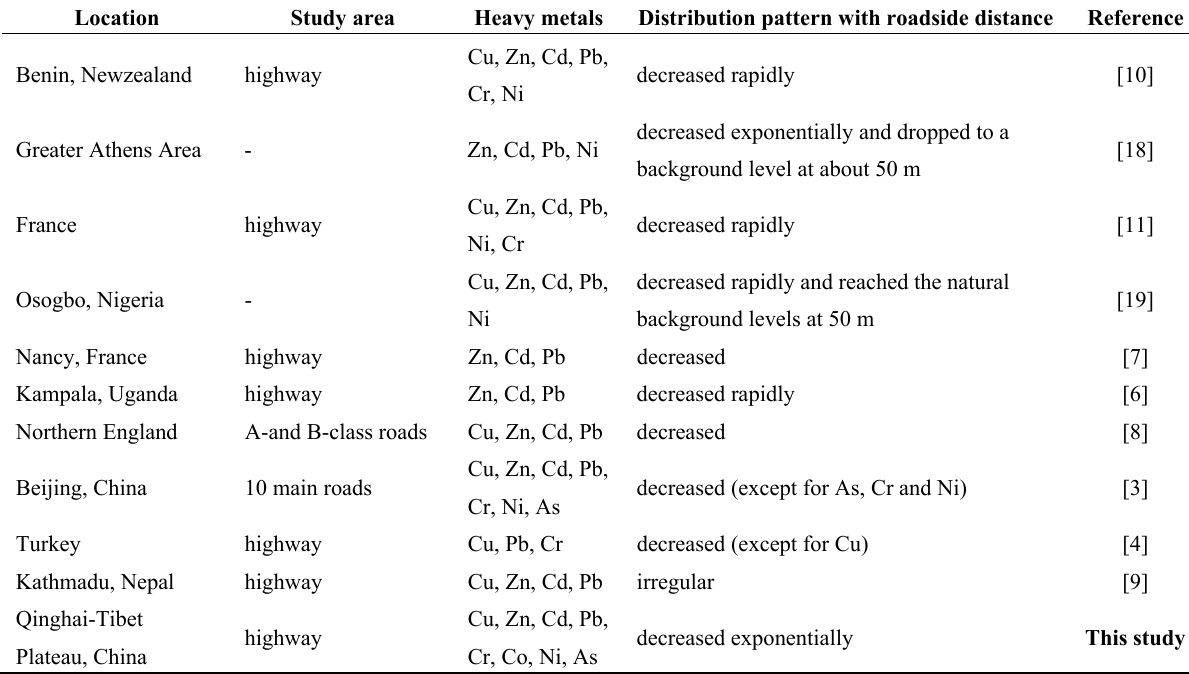
Table 3. Previous studies of heavy-metal distribution patterns in roadside